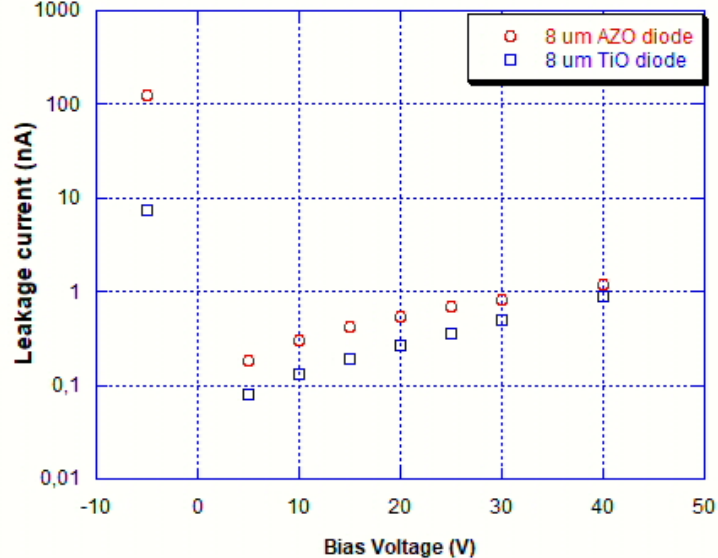
Figure 4. Leakage current vs. bias field for 2 vertical detectors with charge-selective contacts of 8 µm thickness biased up to 5 V/µm electric field: One of the samples was fabricated using TiO 2 electron-selective contact and the other sample was fabricated using ZnO:Al (AZO) electron-selective contact. MoO x /ITO are used in both devices as hole − selective contacts.